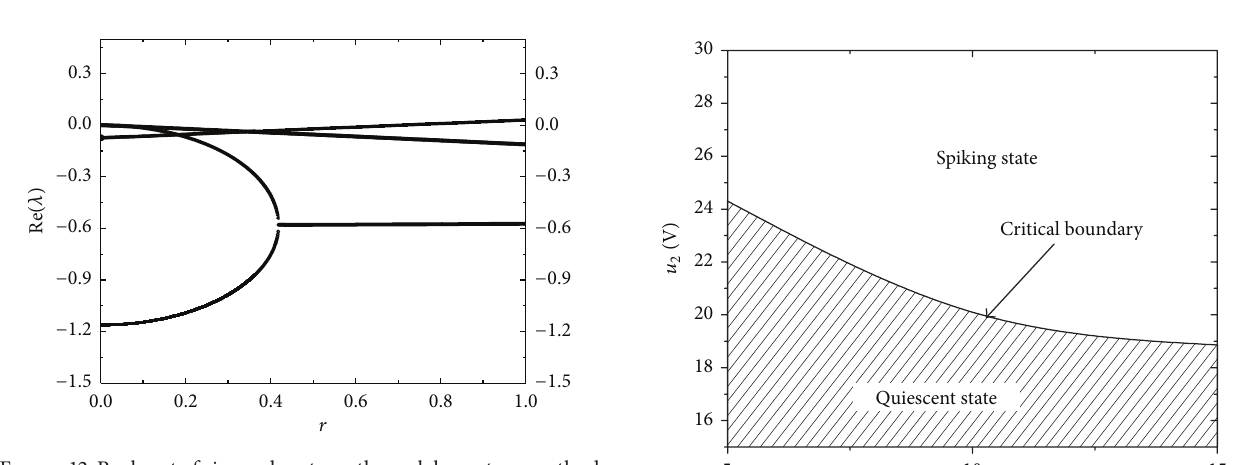
= 5 V, (b) 𝑉 = 10 V, and (c) 𝑉 ref ref